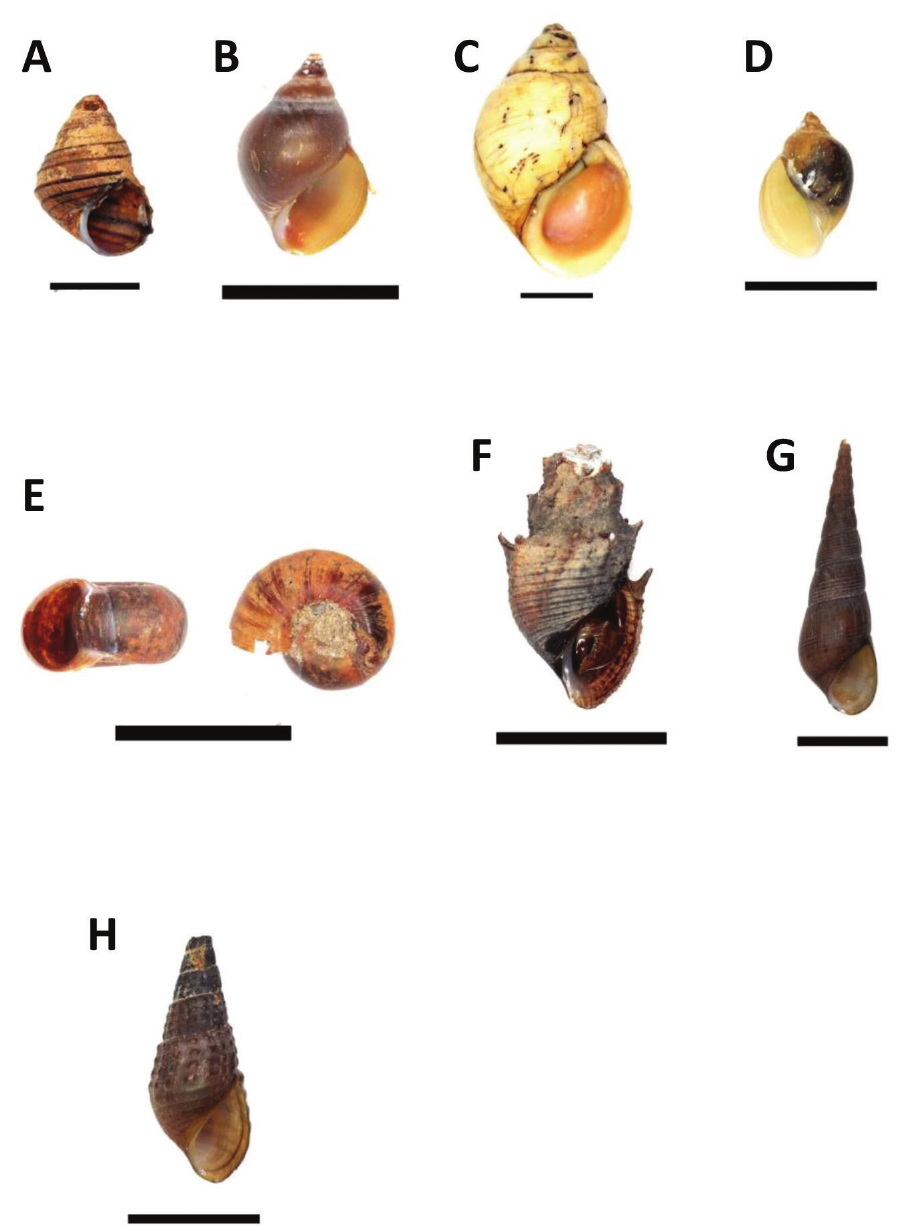
Figure 3. A Family Viviparidae: Sinotaia guangdungensis (Kobelt, 1906) – BOR/MOL 8709 B–C Family Paludomidae. B Paludomus everetti EA Smith, 1894 – BOR/MOL 3398 C Paludomus luteus Adams, 1874 – BOR/MOL 1225 D Family Physidae: Physa acuta Draparnaud, 1805 – BOR/MOL 3451 E Planor- bidae Indoplanorbis exustus (Deshayes, 1834) – BOR/MOL 8681 F–H Family Thiaridae F Mieniplotia scabra (OF Müller, 1774) – BOR/MOL 8310 G Melanoides tuberculata (OF Müller, 1774) – BOR/MOL 6799 H Tarebia granifera (Lamarck, 1822) – BOR/MOL 8688. Scale bars 10